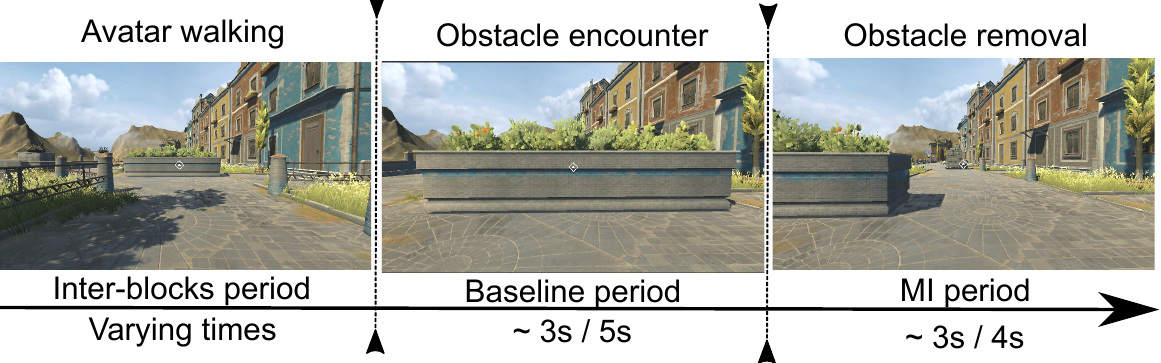
Figure 1. Example of a trial (baseline and MI periods) during the first-person avatar’s walk. The encounter with an obstacle defines the baseline period, whereas its removal from the avatar’s path establishes the onset for gait onset MI.